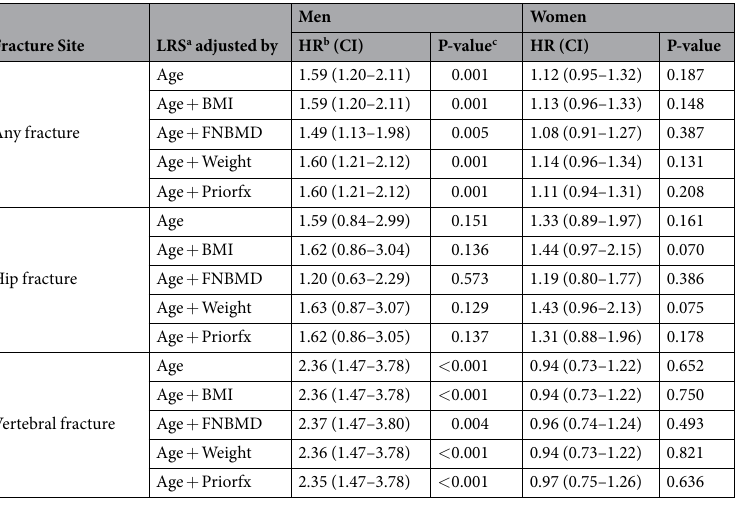
Table 4. Hazard ratio of fracture associated with lifestyle profiling after adjusting for age, body mass index (BMI), femoral neck BMD, and prior fracture. a LRS: Lifestyle Risk Score. LRS in Low/High. Age in ( + 5 years). Weight in (kg). BMI in ( kg = m 2 ). FNBMD: Femoral neck bone mineral density. b HR: Hazard ratio. 95% CI: Confidence intervals of the hazard ratio. c P-value: Global statistical significance of the